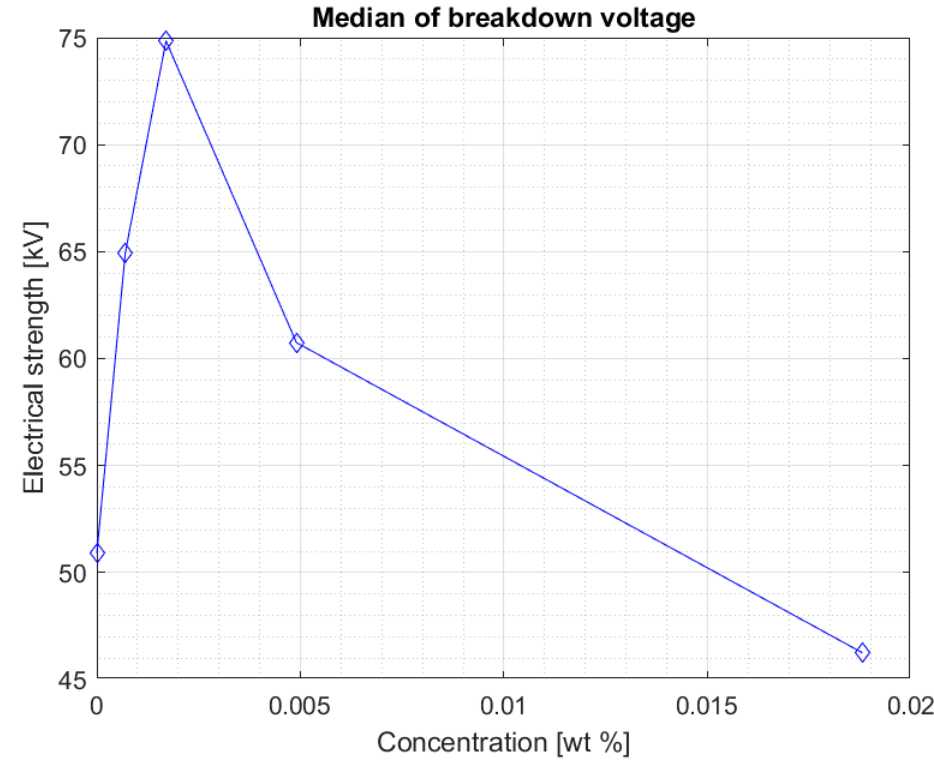
Figure 8. Median of measurement results for each nanofluid after ten weeks mixing.